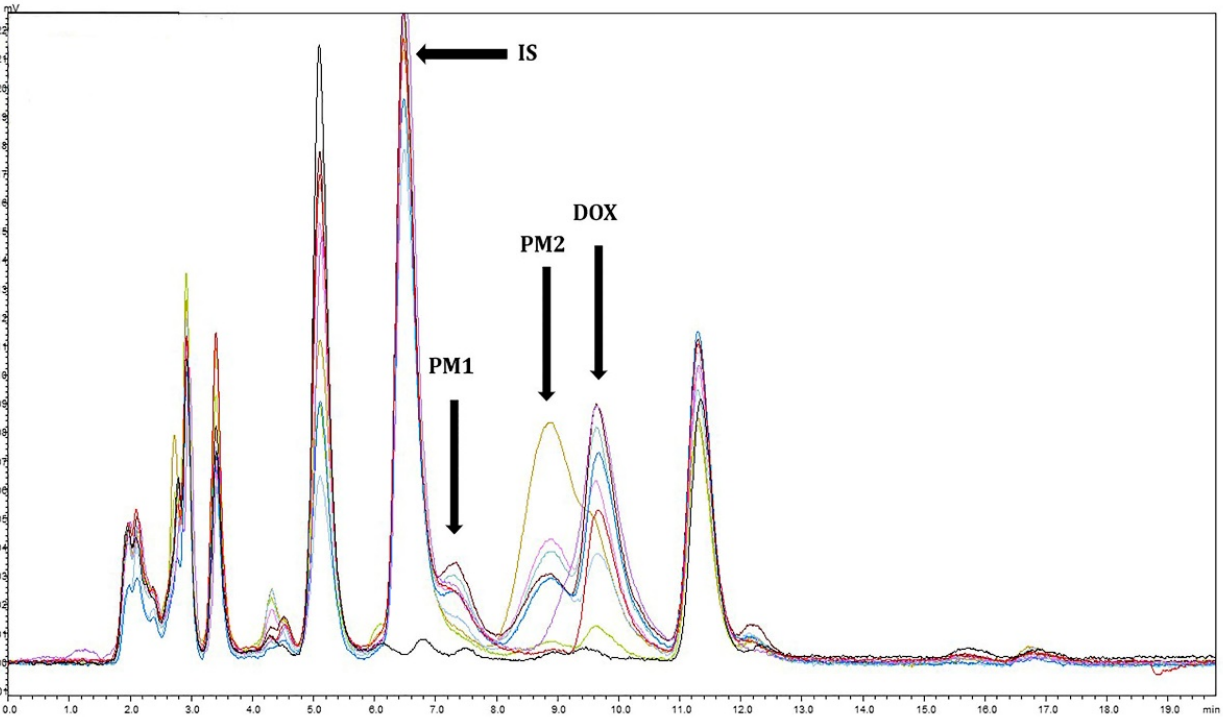
Figure 2. Chromatograms of K3’s plasma 1 h and 672 h after administration of doxycycline at 5 mg/kg via subcutaneous injection (diluted at 50:50 with saline), once a week for four weeks. Each line represents the koala plasma at different time points (T = 0 h (black) to T = 144 h (light green)). Possible metabolites are PM1 and PM2; DOX = doxycycline; IS = internal standard.